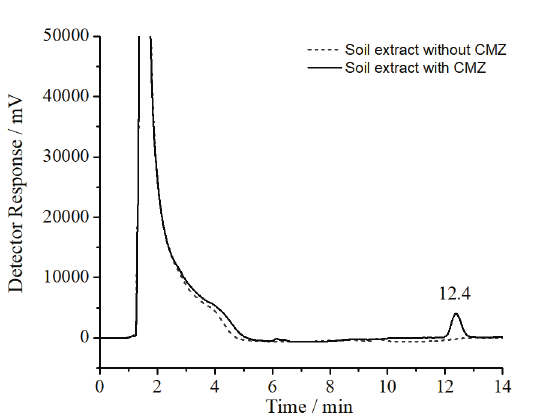
Figure 1 - Chromatograms of extracts of soil amended with 1% biochar in particle size <106 µm: (---) obtained in a 20 mg L -1 CMZ solution (prepared CaCl 250 mg L -1 ); (---) obtained in CaCl herbicide. The samples of soil amended with biochar were placed under stirring for 24 h with these